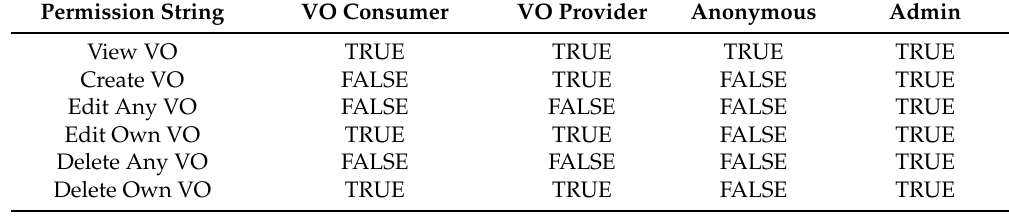
Table 3. A small snapshot of permission and roles management of the proposed application store.